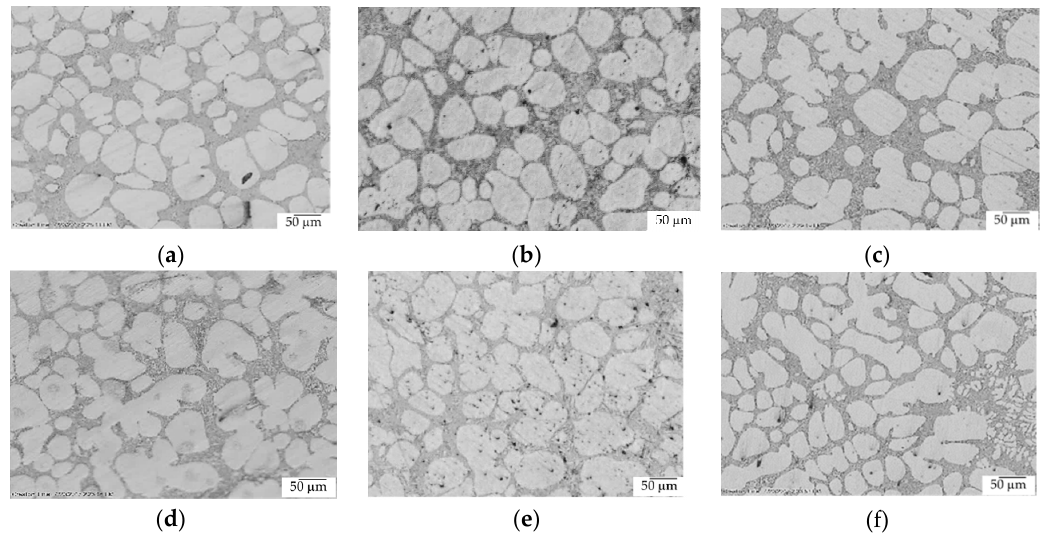
Figure 6. Optical micrographs of stir-cast A356 alloy. ( a ) 300 rpm, 5 min; ( b ) 300 rpm, 10 min; ( c ) 300 rpm, 15 min; ( d ) 500 rpm, 5 min; ( e ) 500 rpm, 10 min; and ( f ) 500 rpm, 15 min.